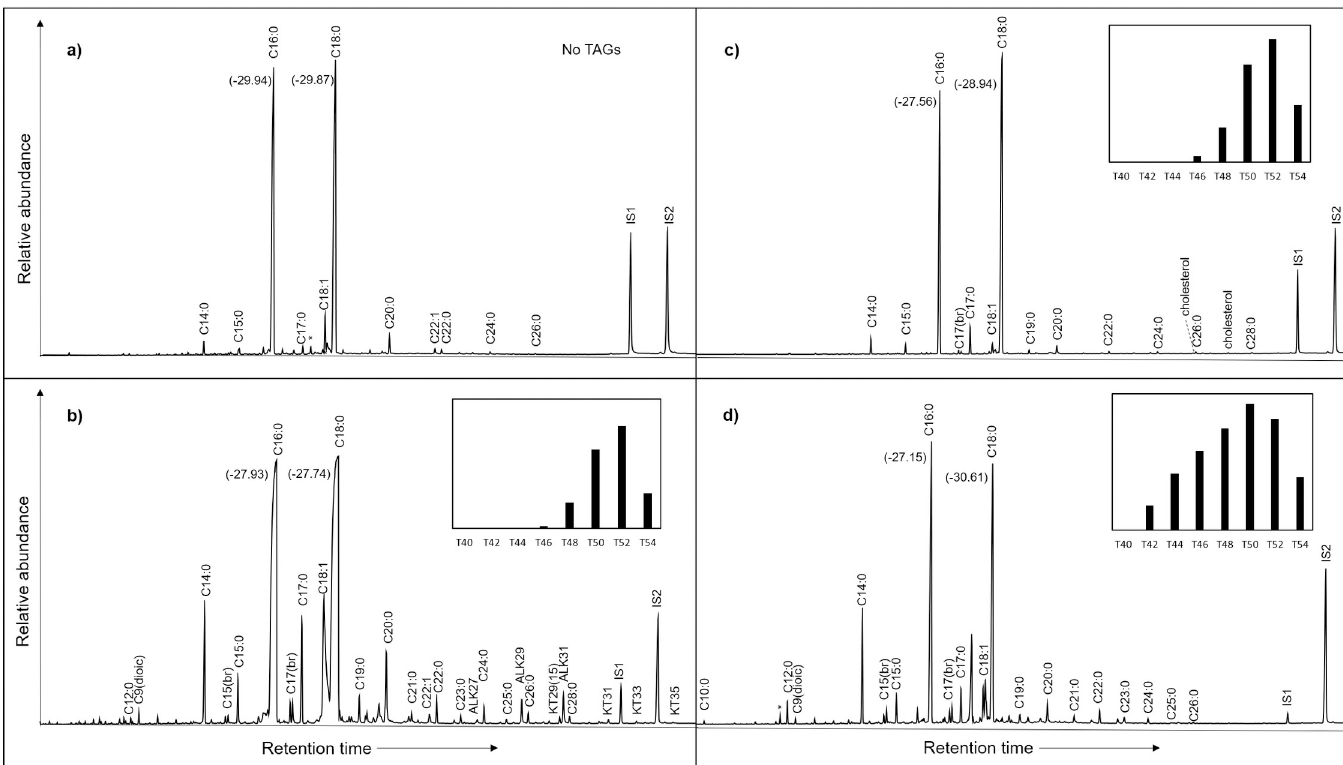
Fig 4. TIC chromatograms of pottery extracts. a) AE chromatogram of sample CSP_25 that yielded δ 13 C values within the range of non-ruminant products, b) AE chromatogram of sample CLESP_29 that yielded δ 13 C values within the range of non-ruminant products (porcine) and shows the TAG distribution profile associated with this sample after SE, c) AE chromatogram of sample GA_34 that yielded δ 13 C values within the range of ruminant products adipose products and shows the TAG distribution profile associated with this sample after SE, d) AE chromatogram of sample CLESP_26 that yielded δ 13 C values within the range of products and shows the TAG distribution profile associated with this sample after SE. Parentheses indicate the δ 13 C 16:0 and δ 13 C 18:0 fatty acid values.